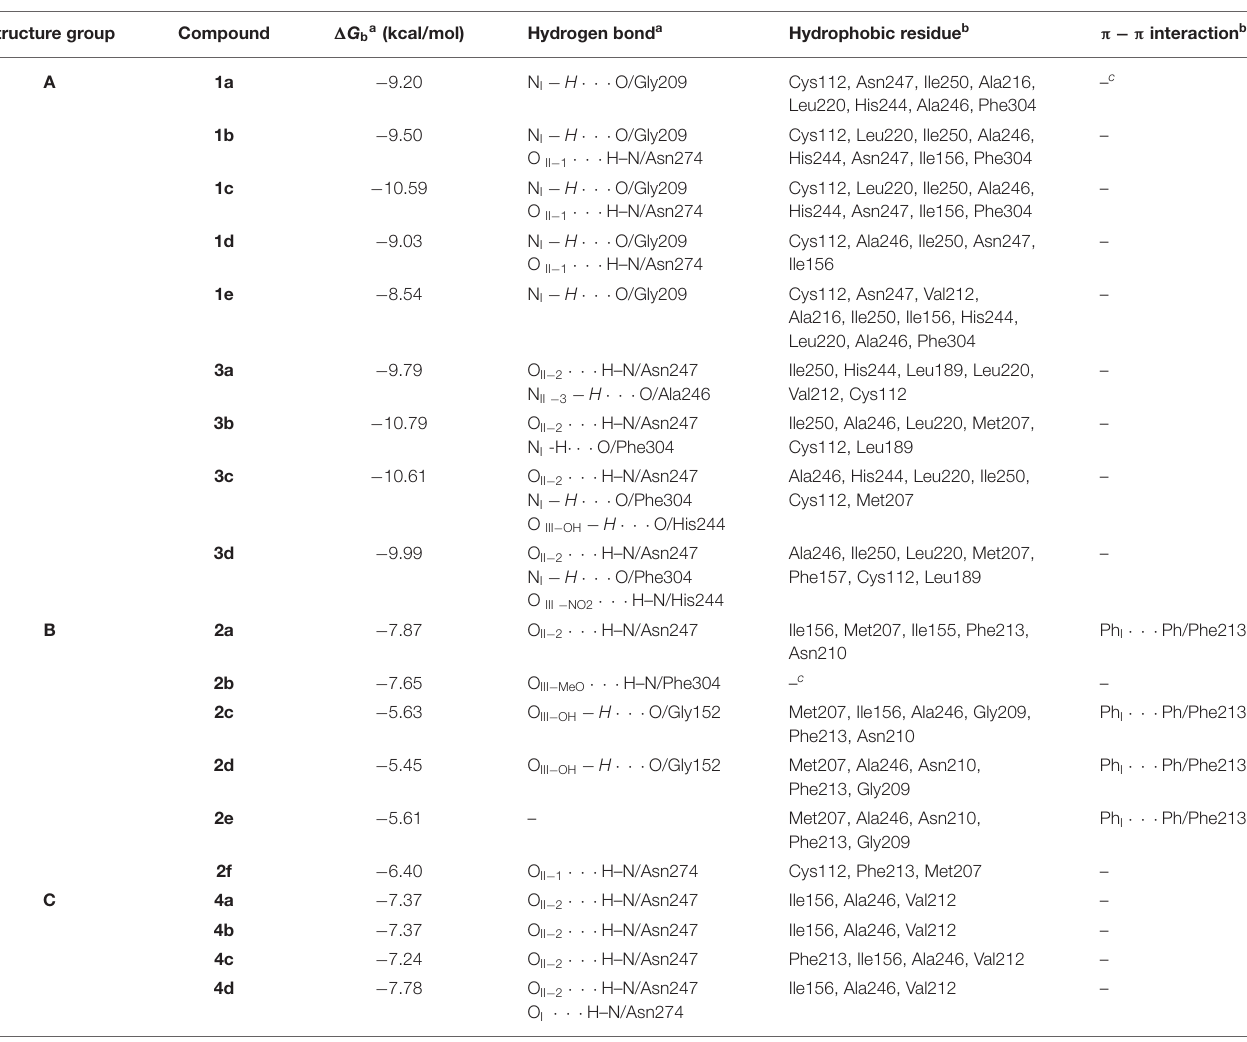
TABLE 2 | The binding affinity of three group indole DKPs with E. coli FabH. Structure